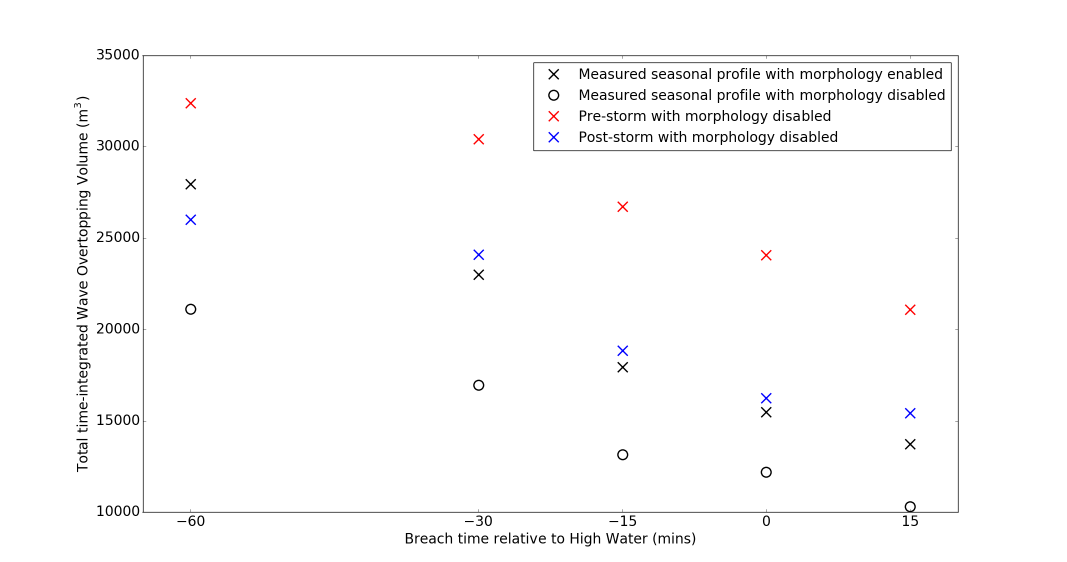
Figure 7. Total time-integrated wave overtopping volume for the duration of the event in Scenario 3 for each morphology setting with a 1-m breach applied at − 60, − 30, 0 and 15 min from high water. Values represent total overtopping volumes for each breaching simulation, rather than cumulative overtopping through the